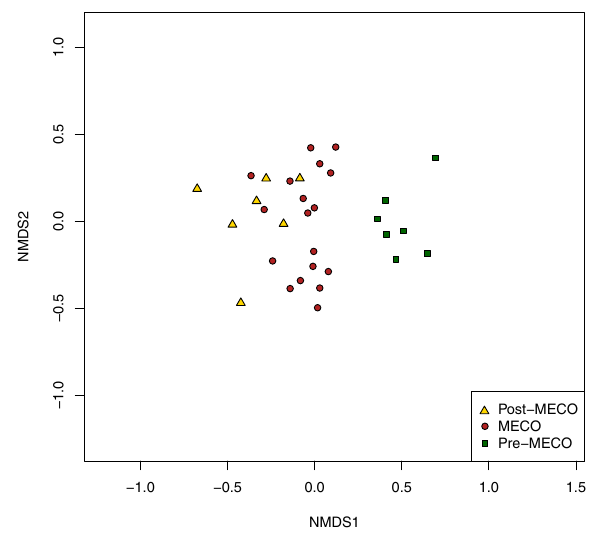
Fig. 7 Distances among fossil-bearing samples in ordination space. Our NMDS analysis supports dissimilarities, especially between pre-MECO against MECO and post-MECO spore-pollen samples. Pre-MECO samples plot to the right on axis 1, occupying a distinct region of the plot while MECO and post-MECO samples slightly